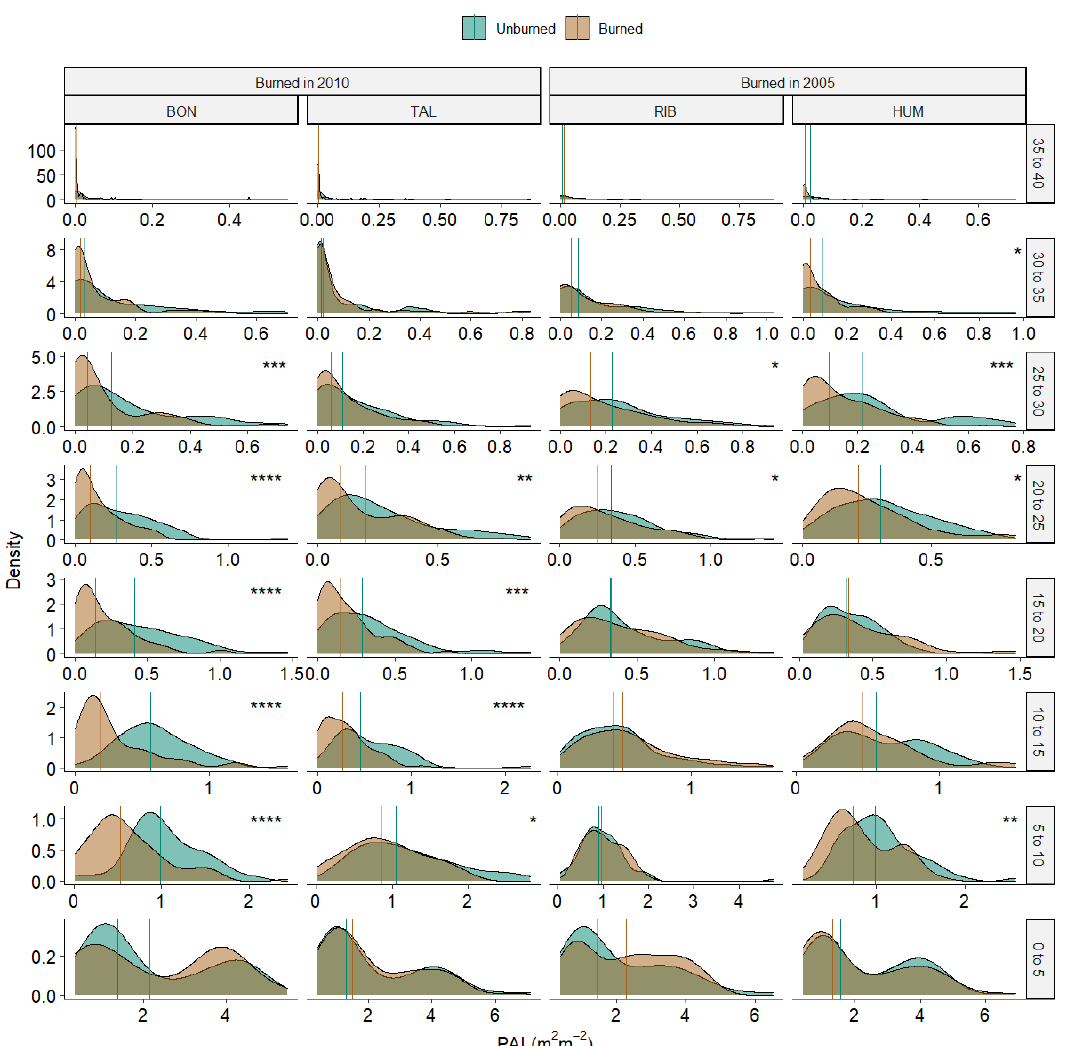
Figure 4. Differences in density distributions for burned and unburned samples of PAI measurements broken down by height class for individual sites. Colored bars represent median values for the different distributions. Stars in the upper right corners of each plot represent significance (p-value) in difference between medians (* <0.05, ** <0.01, *** <0.001, **** <0.0001). Note that each plot axis is on a different scale.